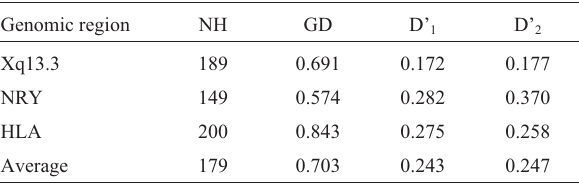
Table 2 - Number of haplotypes (NH), gene diversity (GD) and standard- ized multi-allelic disequilibrium coefficient (D’) for three genomic re- gions in the São Miguel Island population.